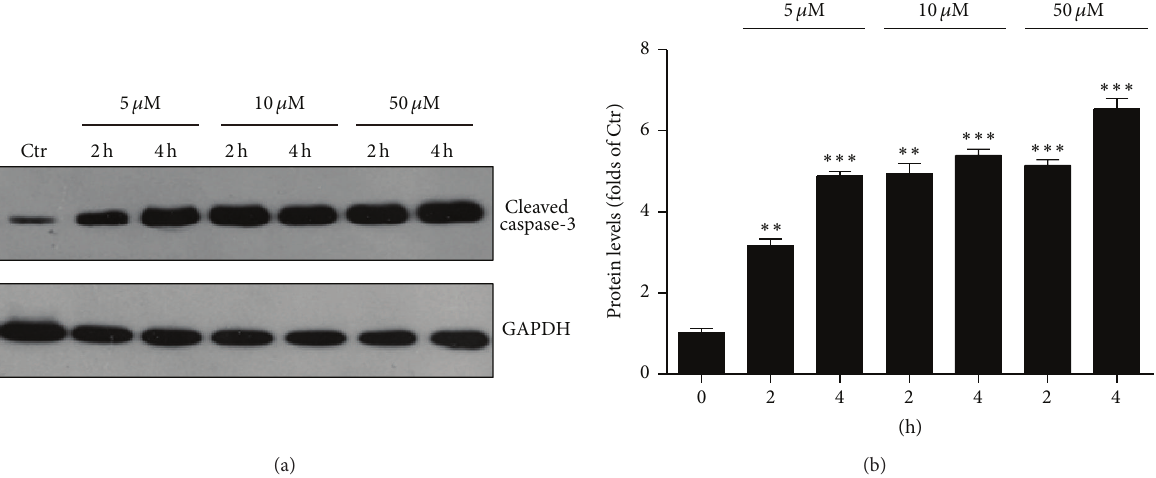
Figure 2: 4-HNE activates caspase-3 in MG63 cells. Western blots (a) and histograms (b) showing the increasing of protein levels of cleaved caspase-3 by 4-HNE treatment (5 to 50 𝜇 M, and 2h to 4h) in MG63 cells. Results are averages of three independent